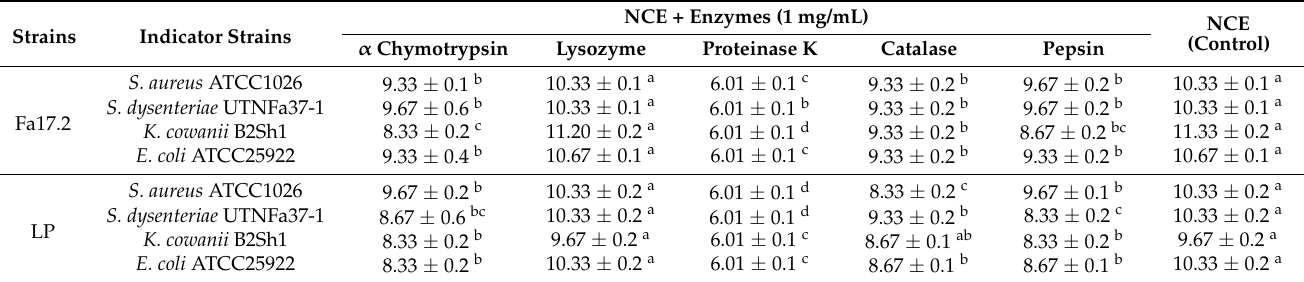
Table 1. Effect of enzymes on the antimicrobial